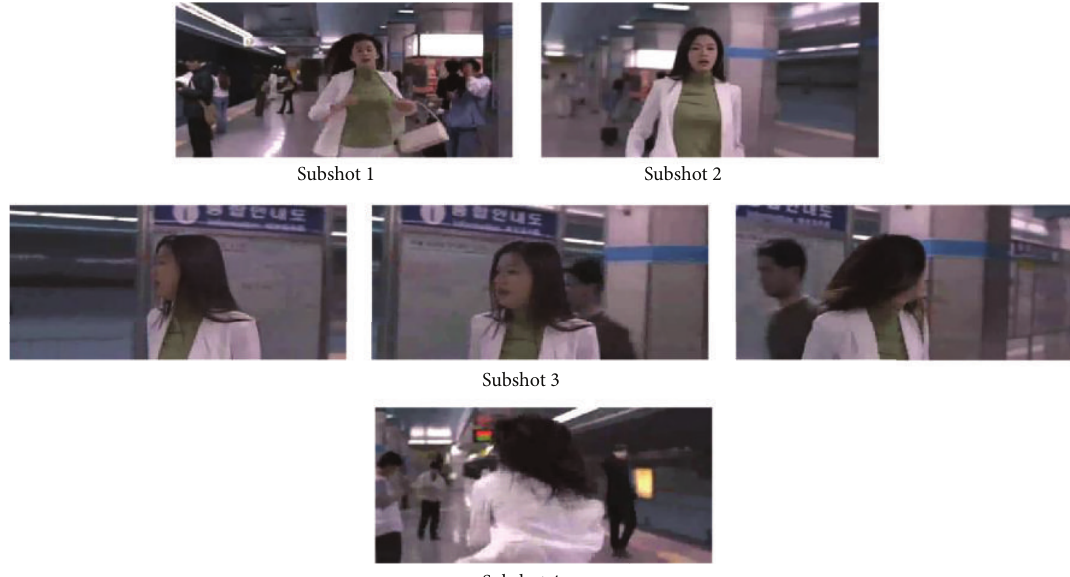
Figure 6: Key-frames extracted from Sassy girl .